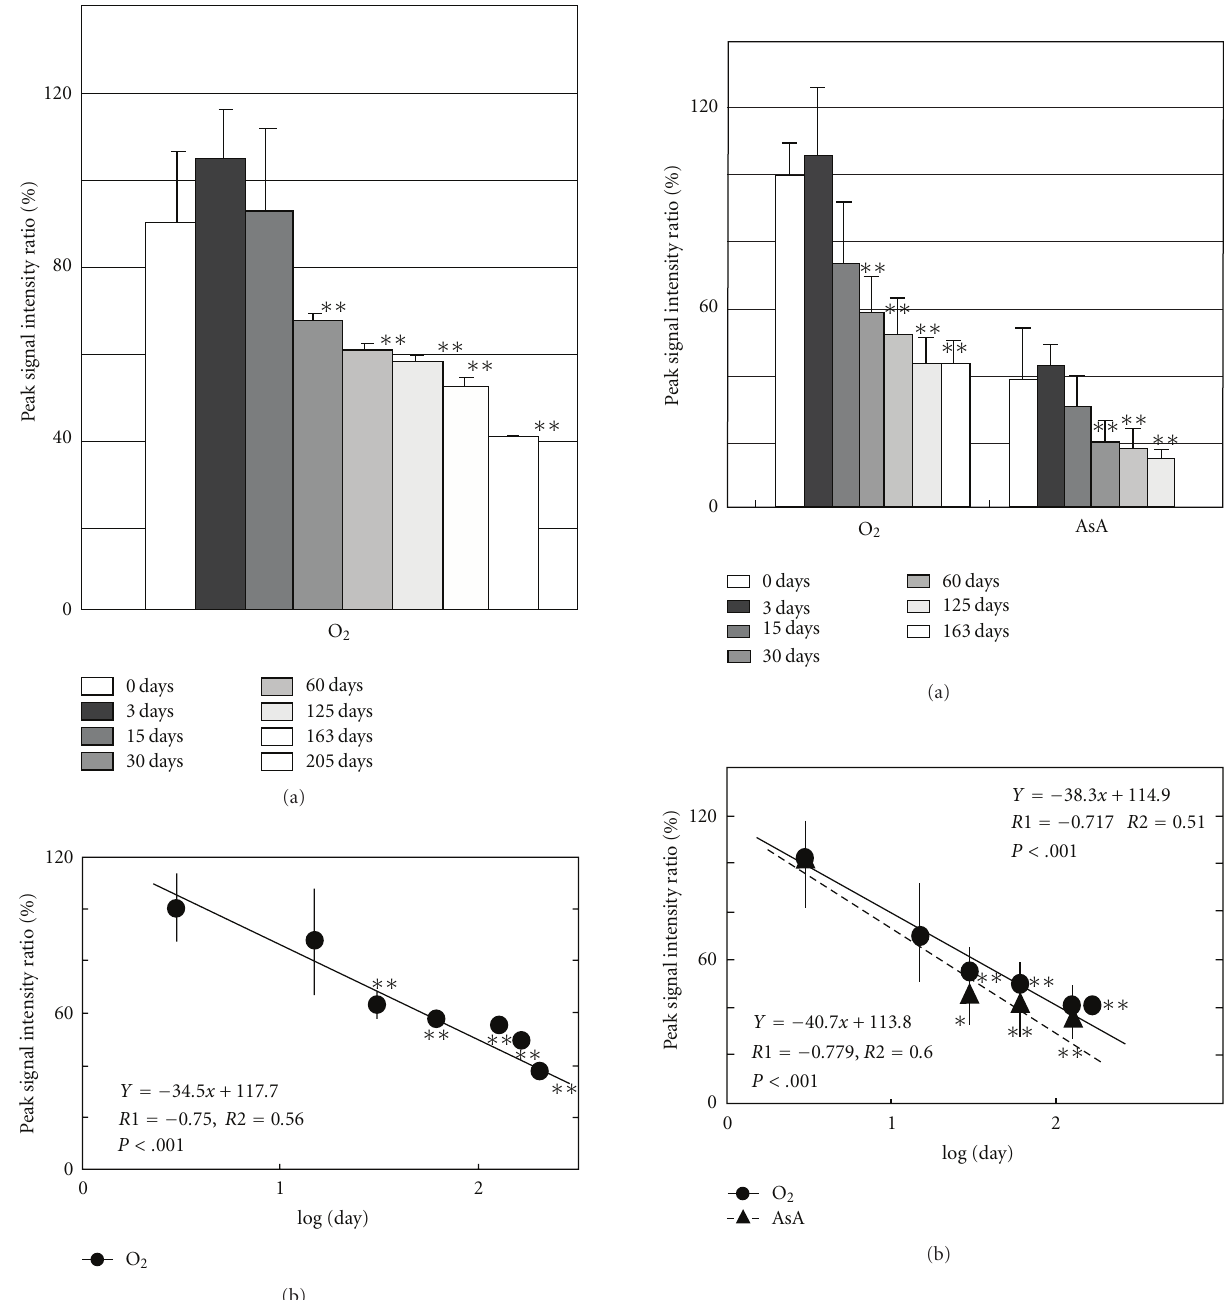
Figure 6: (a) Postmortem DMPO-adduct signal intensity in mouse liver. The columns and the lines show the postmortem signal intensity ratio of brain and S.E.M. of the means ( n = 8). The y - axis shows the percentage of peak signal intensity ratio, which was calculated by assuming that the intensity of MnO (500nmol/L) was 100%. ∗ P < . 05, ∗∗ P < . 01, versus 0 days. (b)Time course of postmortem DMPO-adduct signal intensity ratio in mouse liver. The y-axis shows the percentage of peak signal intensity, which was calculated by assuming that the intensity at 3 day postmortem was 100%. X -axis is expressed in Log(day). ∗ P < . 05, ∗∗ P < . 01, versus 3 days. The regression lines, correlation coe ffi cient ( R1 ), contribution rate ( R2 ) and the probability of error ( P -value) were